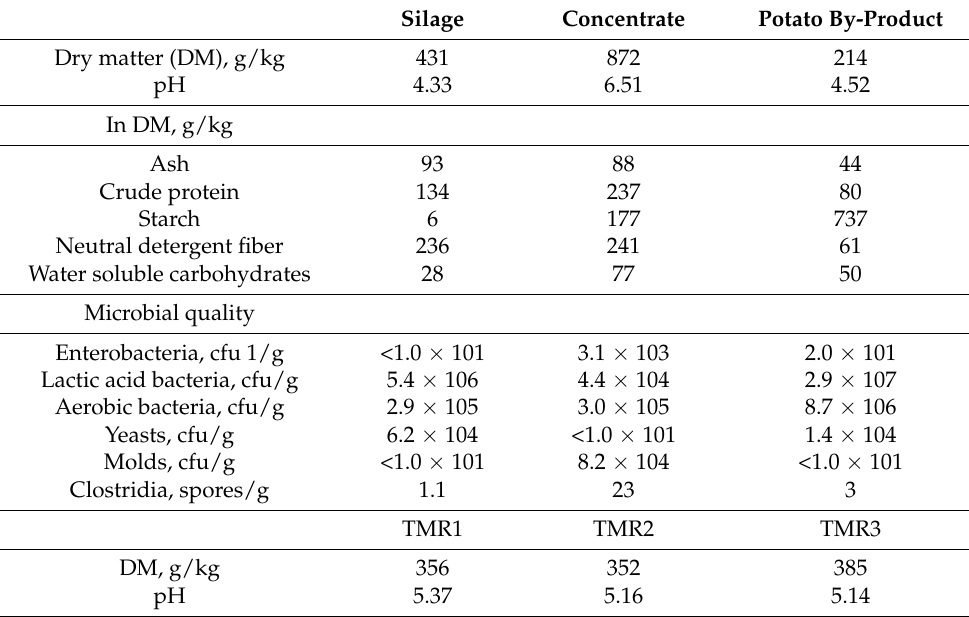
Table 7. Composition and microbial quality of the feeds, and dry matter and pH of different total mixed rations (TMR) in the aerobic stability experiment (Experiment 2). Silage Concentrate Potato